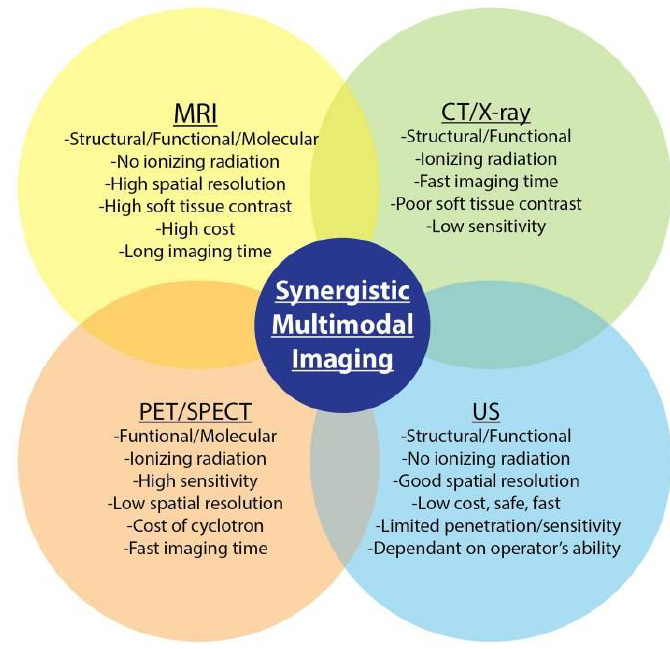
Figure 12. Overview of multimodal imaging applications and their advantages and disadvantages. Reproduced with permission from Ref. [143].